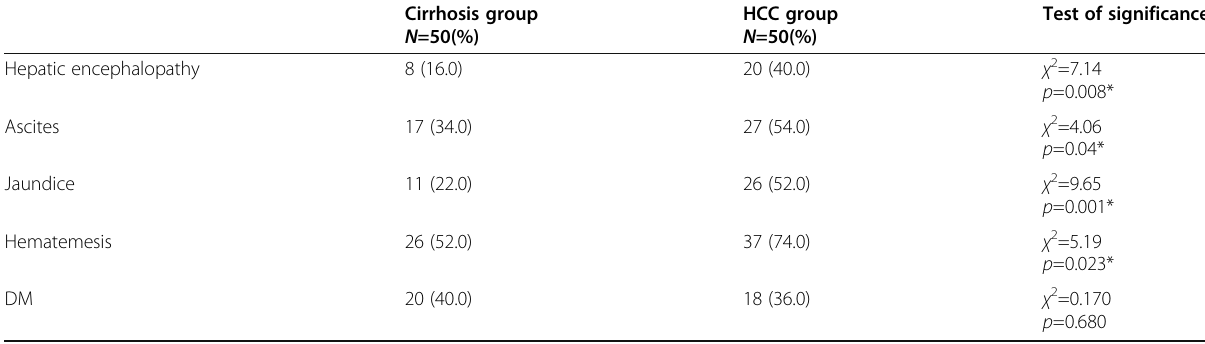
Table 2 clinical presentation of the studied